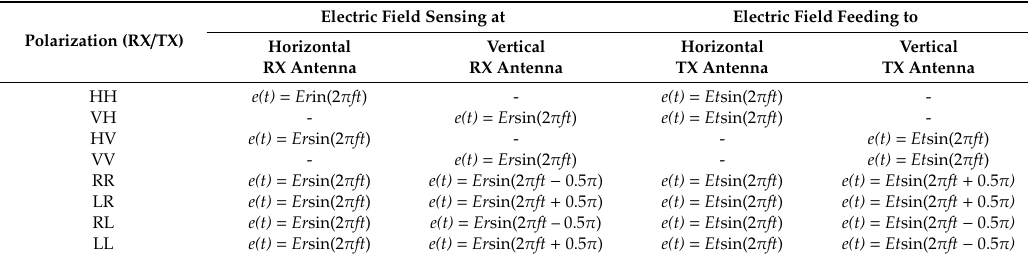
Table 2. Theoretical wave feeding, wave sensing and phase shifting for linearly polarized (LP) and circularly polarized (CP)